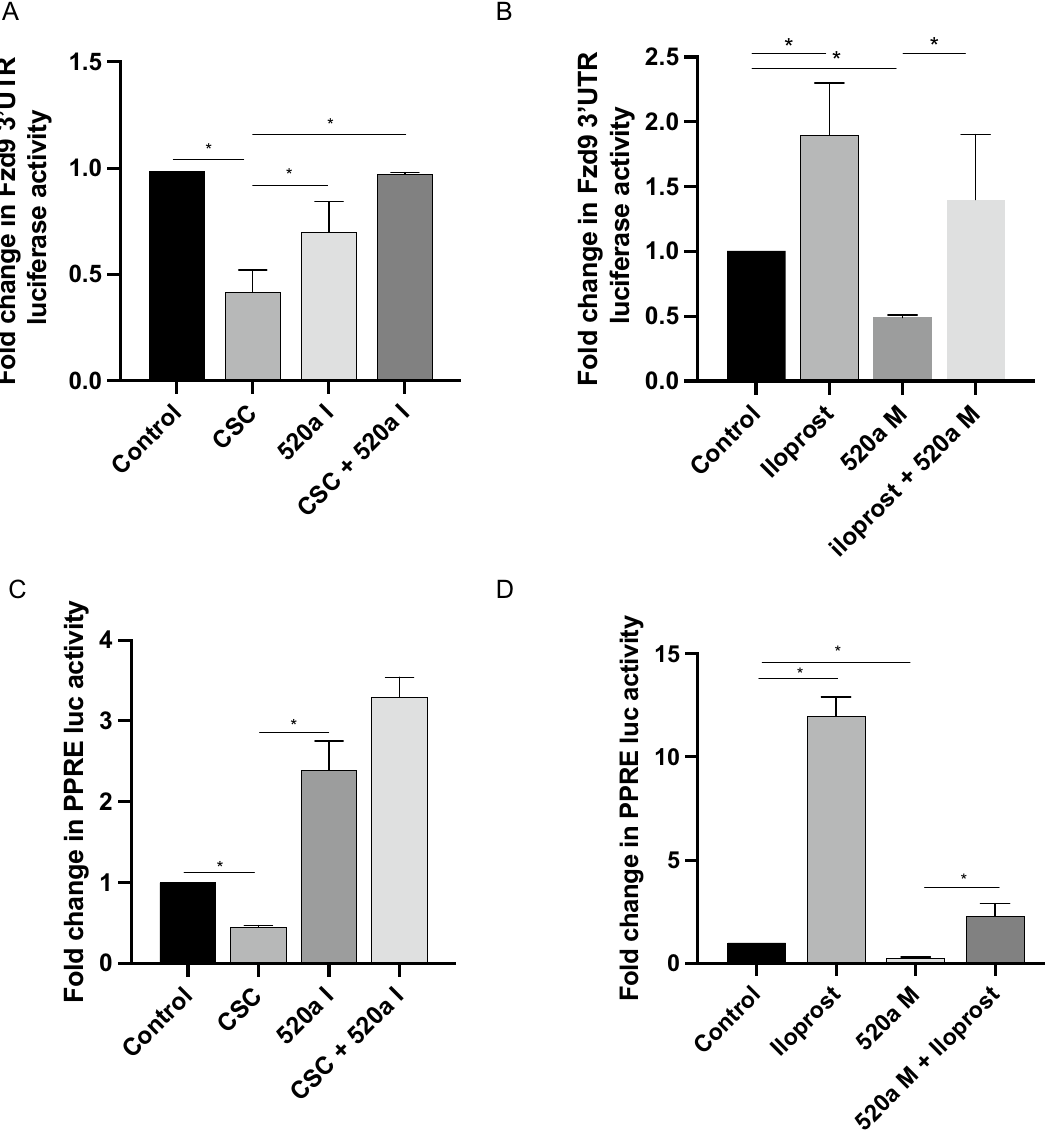
Figure 5. Iloprost and miR-520a-5p inhibition rescue the effects of miR-520a expression and CSC. Transfected FZD9 3’UTR activity ( A ) and PPRE activity ( C ) in the A549 cell line with 48 h of 20 µg/ml CSC exposure and/ or a miR-520a-5p inhibitor. Transfected FZD9 3’UTR luciferase activity ( B ) and PPRE luciferase activity ( D ) with 48 h of 10 μM iloprost treatment and/or a miR-520a mimic. Luciferase activity was measured in duplicate and shown relative to control. 520a I, miR-520a-5p inhibitor; 520a M, miR-520a-5p mimic. * p <